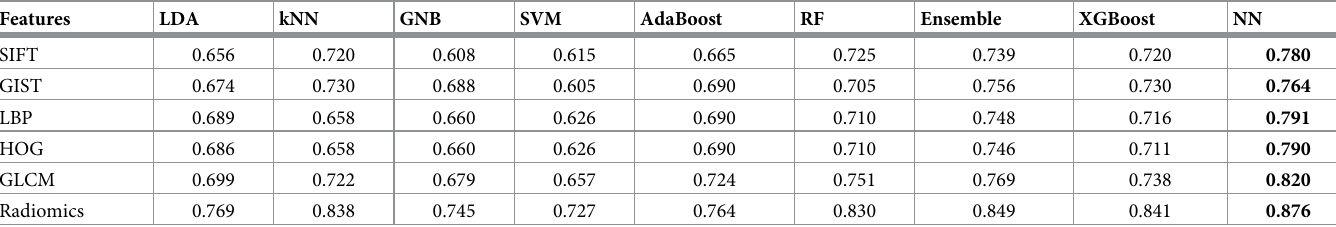
Table 3. Classification accuracy obtained using handcrafted and radiomic features.